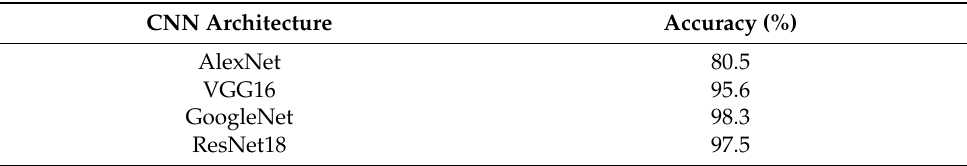
Table 5. Comparison of the Confusion